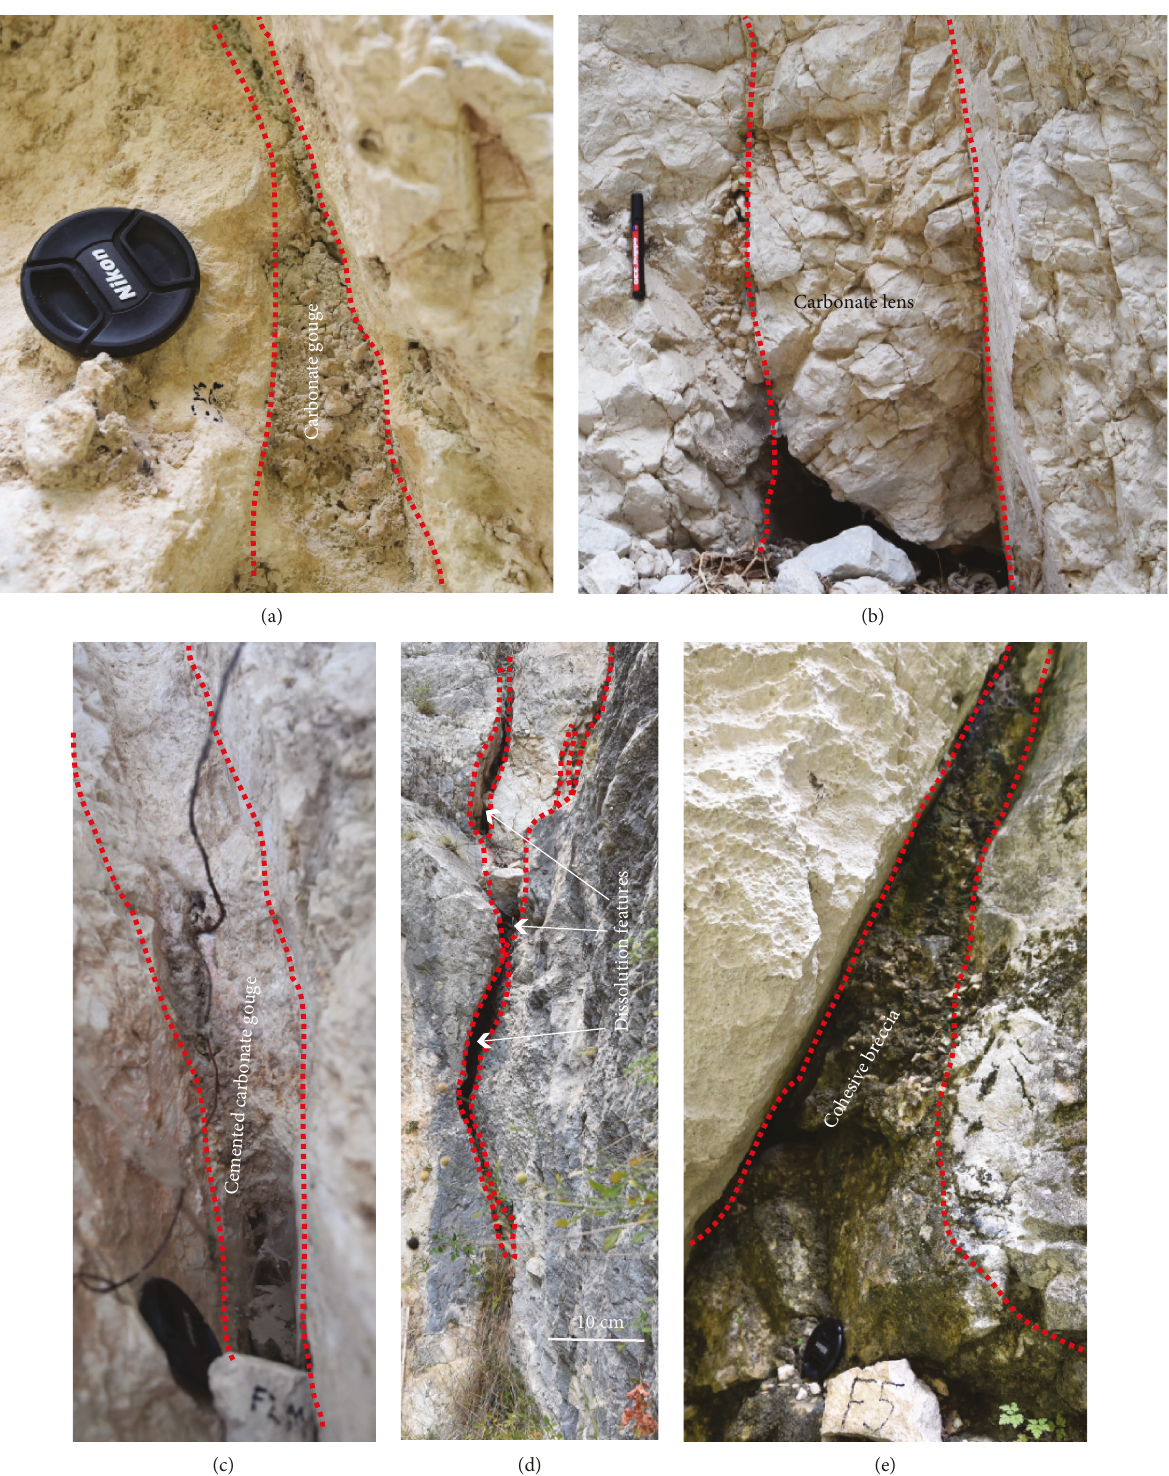
Figure 9: Di ff erent fault rocks observed in the studied fault cores in Vallone di Santo Spirito, Maiella. (a) Beige carbonate gouge observed in the fault core of a right-lateral strike-slip fault. Note the carbonate fragments that are incorporated in the gouge. (b) Carbonate lens trapped in the fault core of a right-lateral strike-slip fault. (c) White-brownish cemented fault gouge located in the fault core of a right-lateral strike-slip fault. (d) Dissolution features formed in dilation jogs along a strike-slip fault. (e) A cohesive breccia pocket observed in the fault core of a left- lateral strike-slip